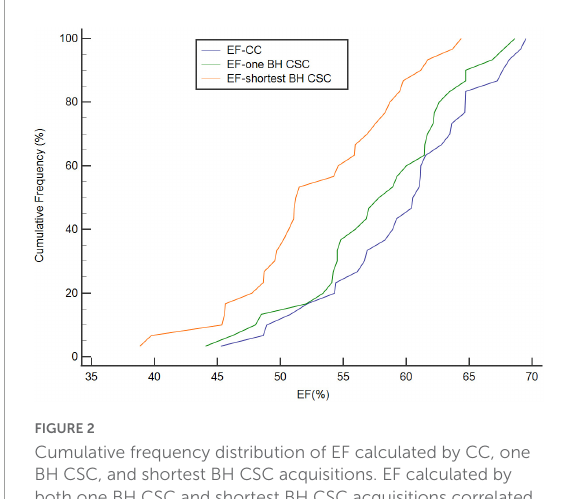
FIGURE2 Cumulative frequency distribution of EF calculated by CC, one BH CSC, and shortest BH CSC acquisitions. EF calculated by both one BH CSC and shortest BH CSC acquisitions correlated well with that calculated by CC acquisition (ICC = 0.955 and 0.836,